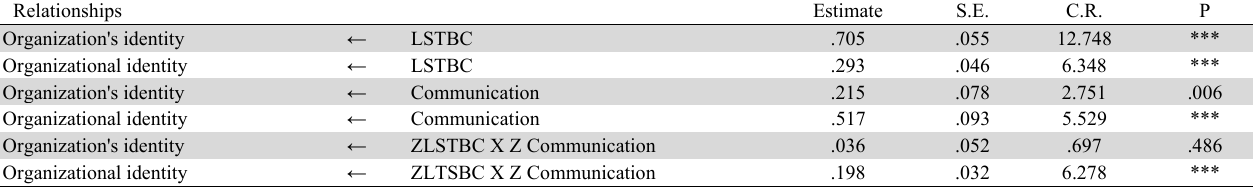
Results of study model hierarchical regression analysis